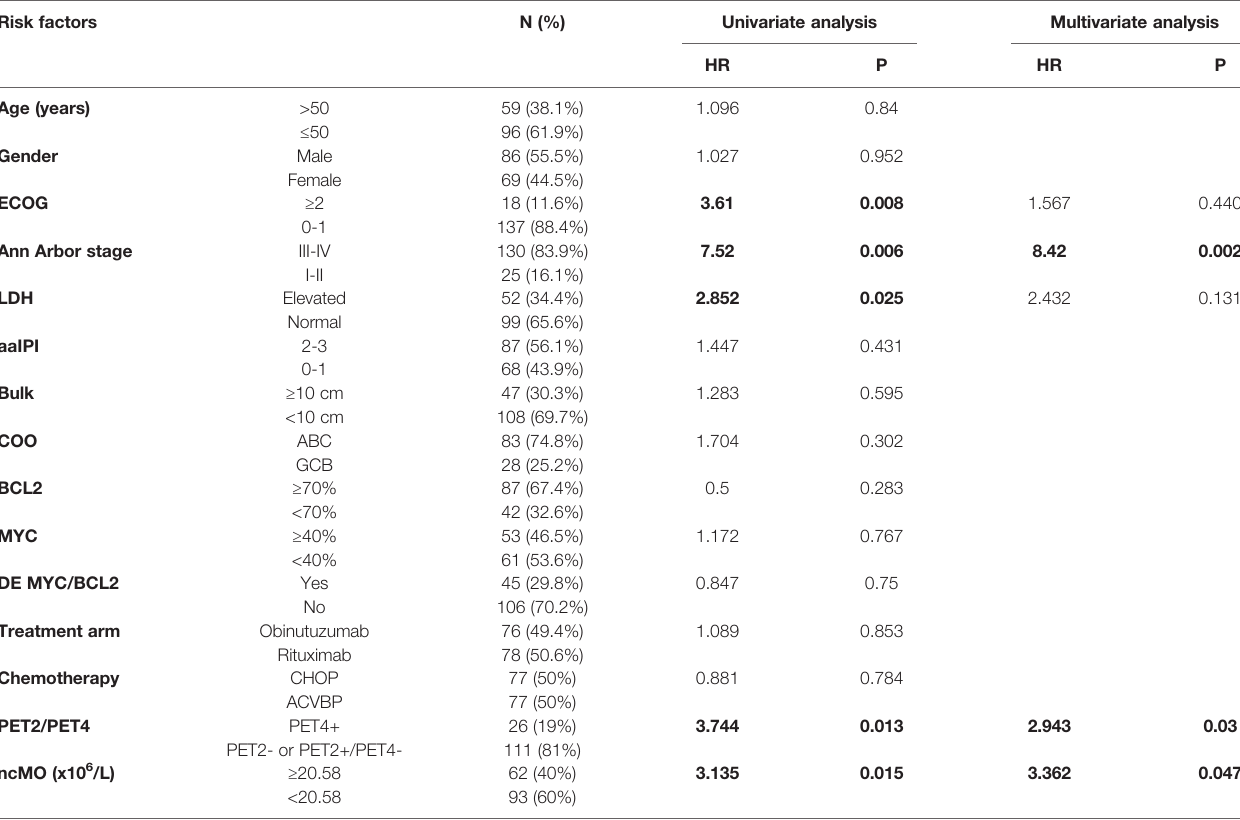
TABLE 2 | Factors in fl uencing overall survival in validation cohort. Risk factors N